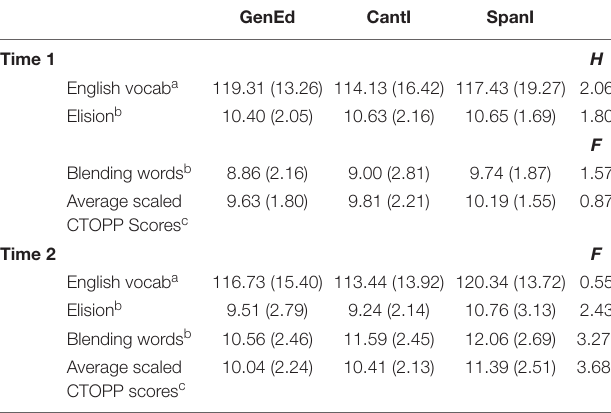
TABLE 3 | Mean (SD) performance on neuropsychological